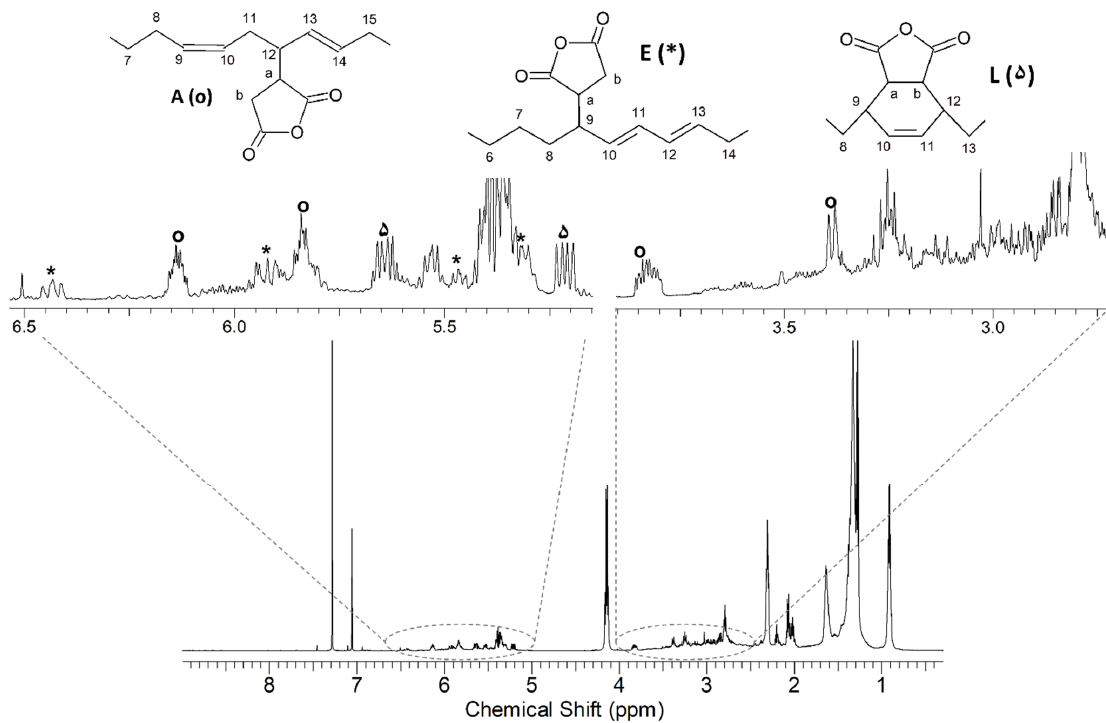
Figure 5. 1 H NMR spectrum of the reaction product of ethyl linoleate with MA; the signals are highlighted by different symbols: ۵ compound A ; * compound E (or F ); ο compound L (or M ) of Scheme 3.